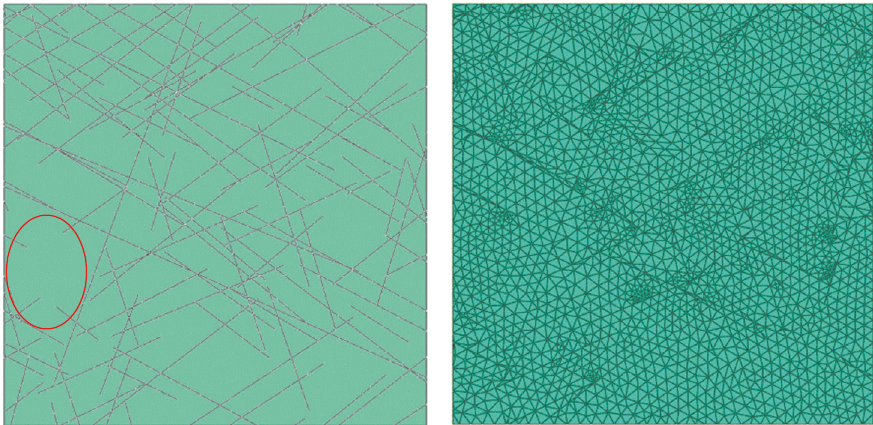
Figure 17: A certain fracture network model inside the length of 2 m and its meshes.